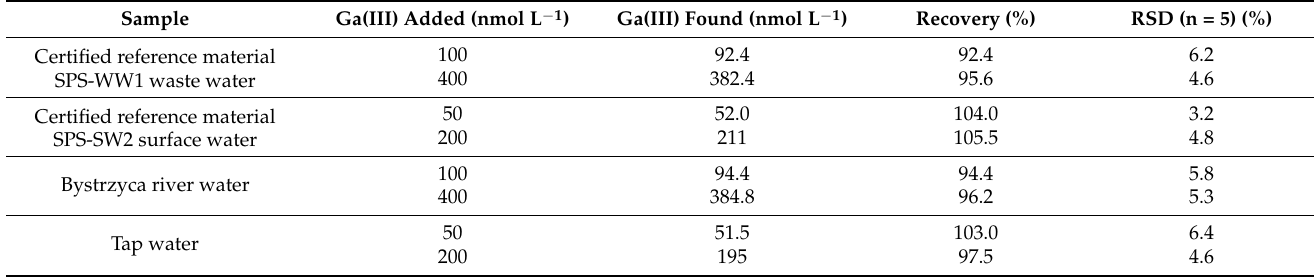
Table 1. Analytical results of Ga(III) determination in certified reference materials and natural water samples. The samples were analyzed after tenfold dilutions using the standard addition